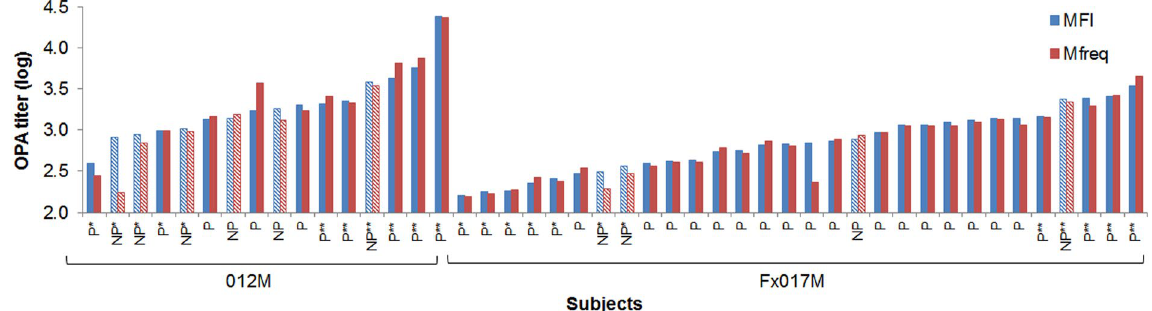
Figure 1. Phagocytic activity by subjects in 012M and Fx017M cohorts. OPA, as measured by MFI (red) and Mfreq (blue) OPA titers for each subject in the 012M and Fx017M cohorts, denoted by their protection status as protected (‘P’, solid bars) or not protected (‘NP’, hatched bars). Subjects selected for low and high phagocytic activity pools are shown as ‘ * ’ and ‘ ** ’, respectively, for both cohorts.